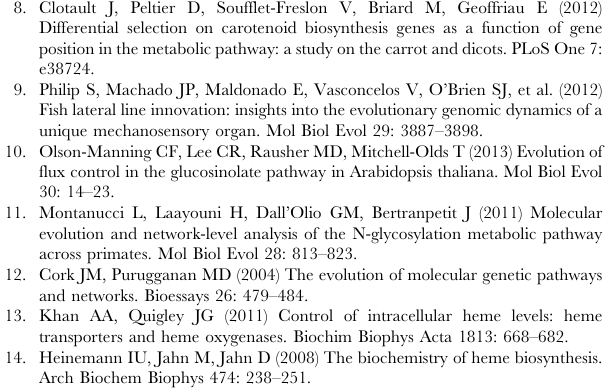
Figure S3 The collection of figures for the maximum likelihood phylogeny of protein sequences for eight genes of heme biosynthesis pathway in animals. Boot- strap values . 70% are indicated. The bootstrap values are displayed only for the branches of the main lineages. (A) ALAS, (B) FECH. Table S1 Model test (M1a) for selection of genes in heme biosynthesis pathway. Table S2 Length of evolutionarily conserved DNase- hypersensitive sites in intron sequences. Table S3 Potential IRE in eight genes of heme biosyn- thesis pathway. Table S4 Genomewide detection of potential IRE in exon-intron boundary in human and zebrafish genes. Table S5 Potential HRM in eight genes of heme biosynthesis pathway (HRM_t and HRM_r). Table S6 Length of evolutionarily conserved DNase- hypersensitive sites in intron sequences (bps) for Abcg2 , Ank1 and Slc11a2 . Table S7 IDs of genes of heme biosynthesis pathway in animals. Table S8 Number of sequences by taxonomic groups. Table S9 Species by taxonomic